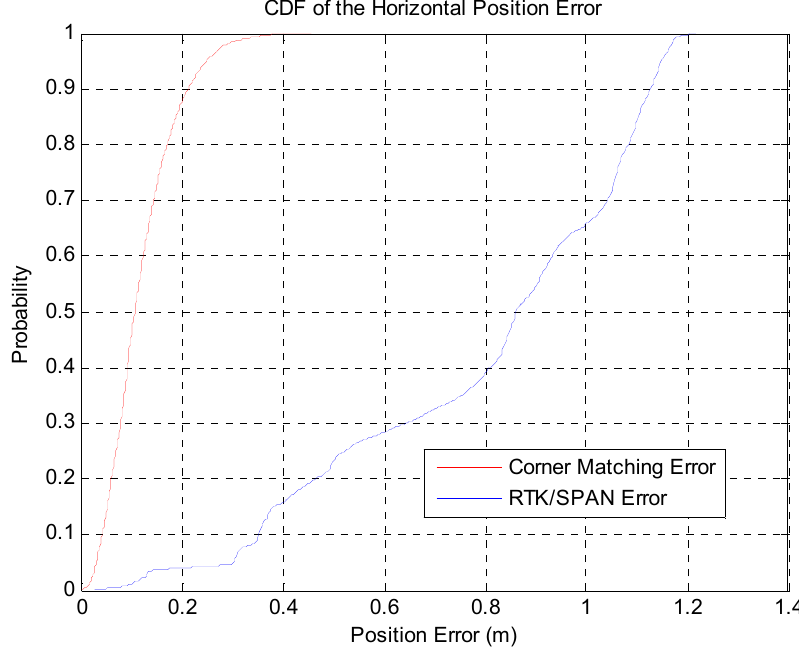
Figure 19. CDF of the horizontal vehicle position error.